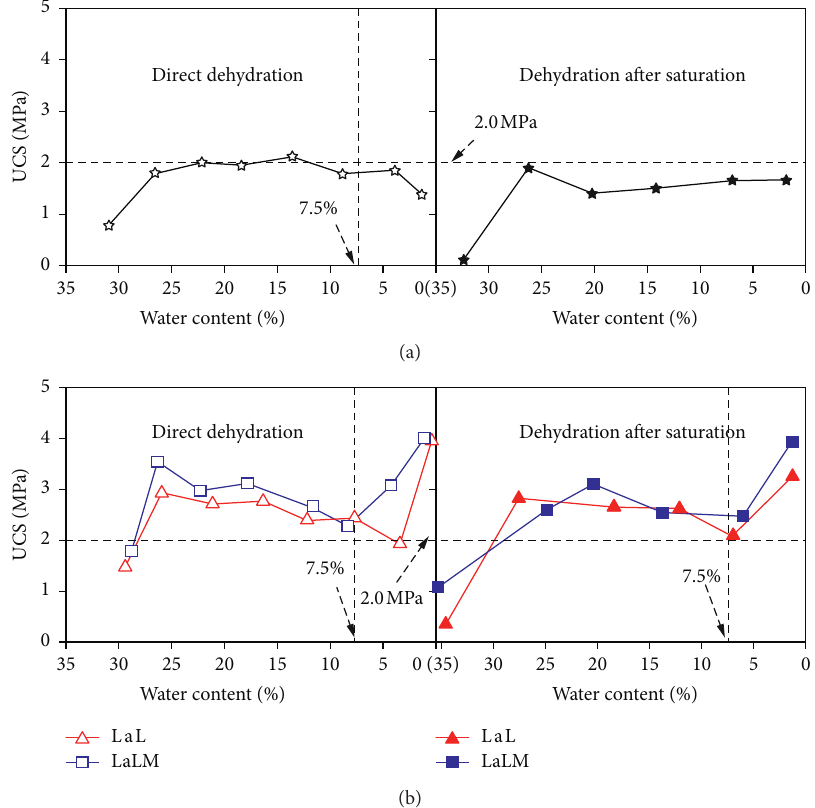
Figure 10: UCS as a function of water content. (a) Laterite. (b) Treated laterite.